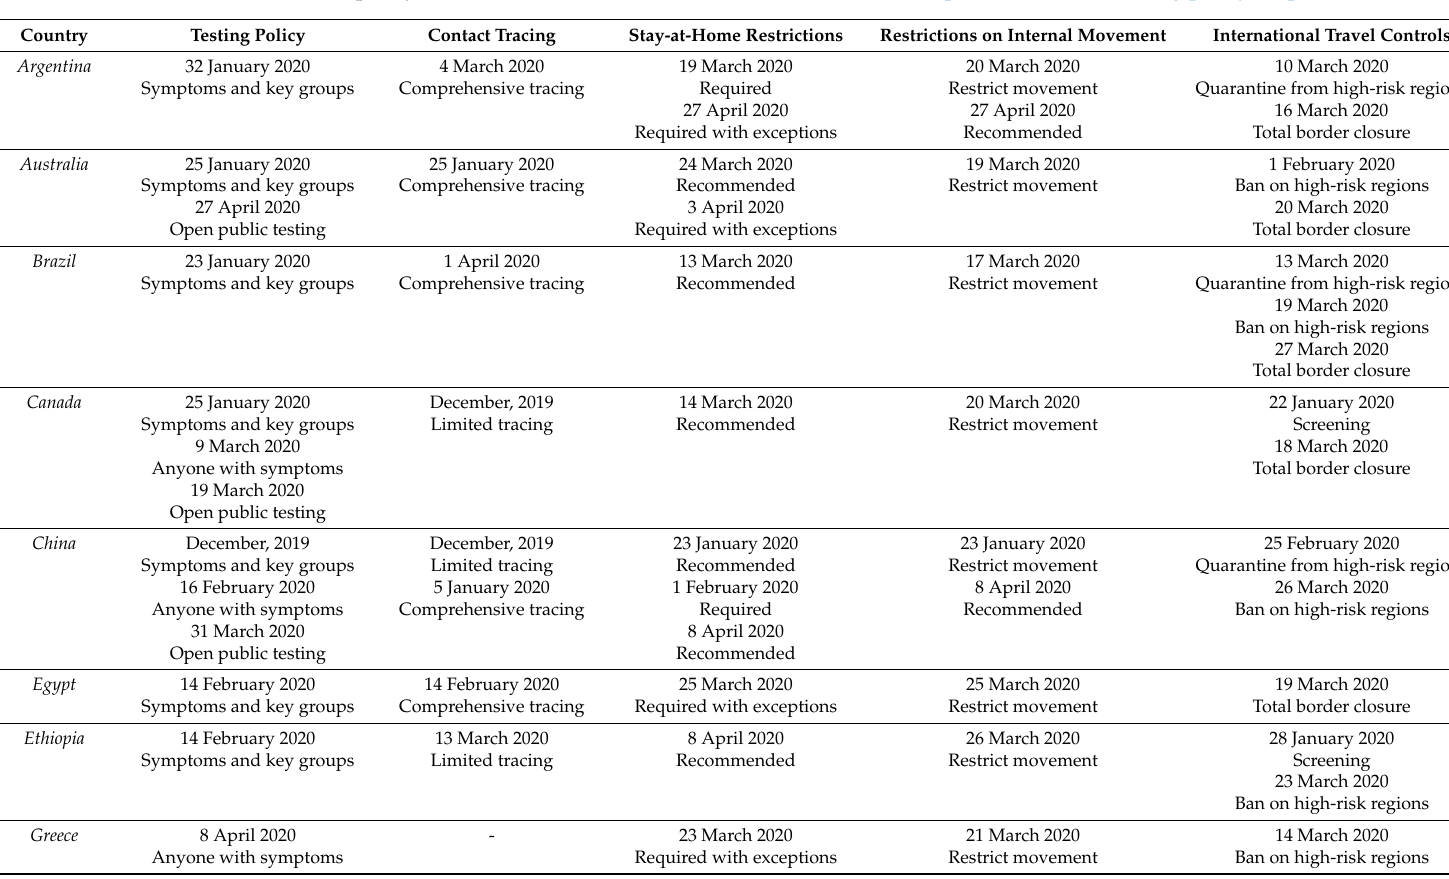
Table 3. Testing, contact tracing and movement restrictions (the first wave COVID-19, until 1.05.20) (created using Oxford COVID-19 Government Response